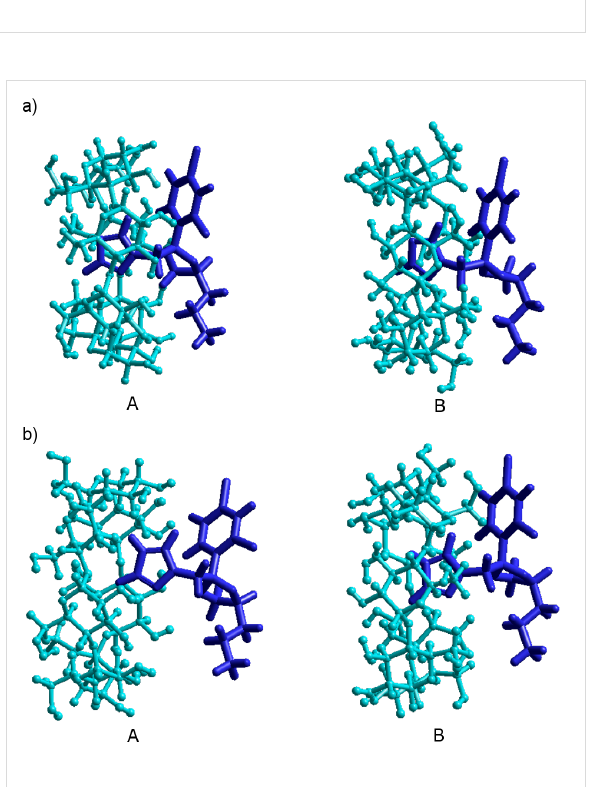
Figure 10: MM+ optimized molecular geometry of the (a) β -CD/PP and (b) β -CD/PPH + inclusion complexes, in both A and B configurations. For clarity, water molecules have been